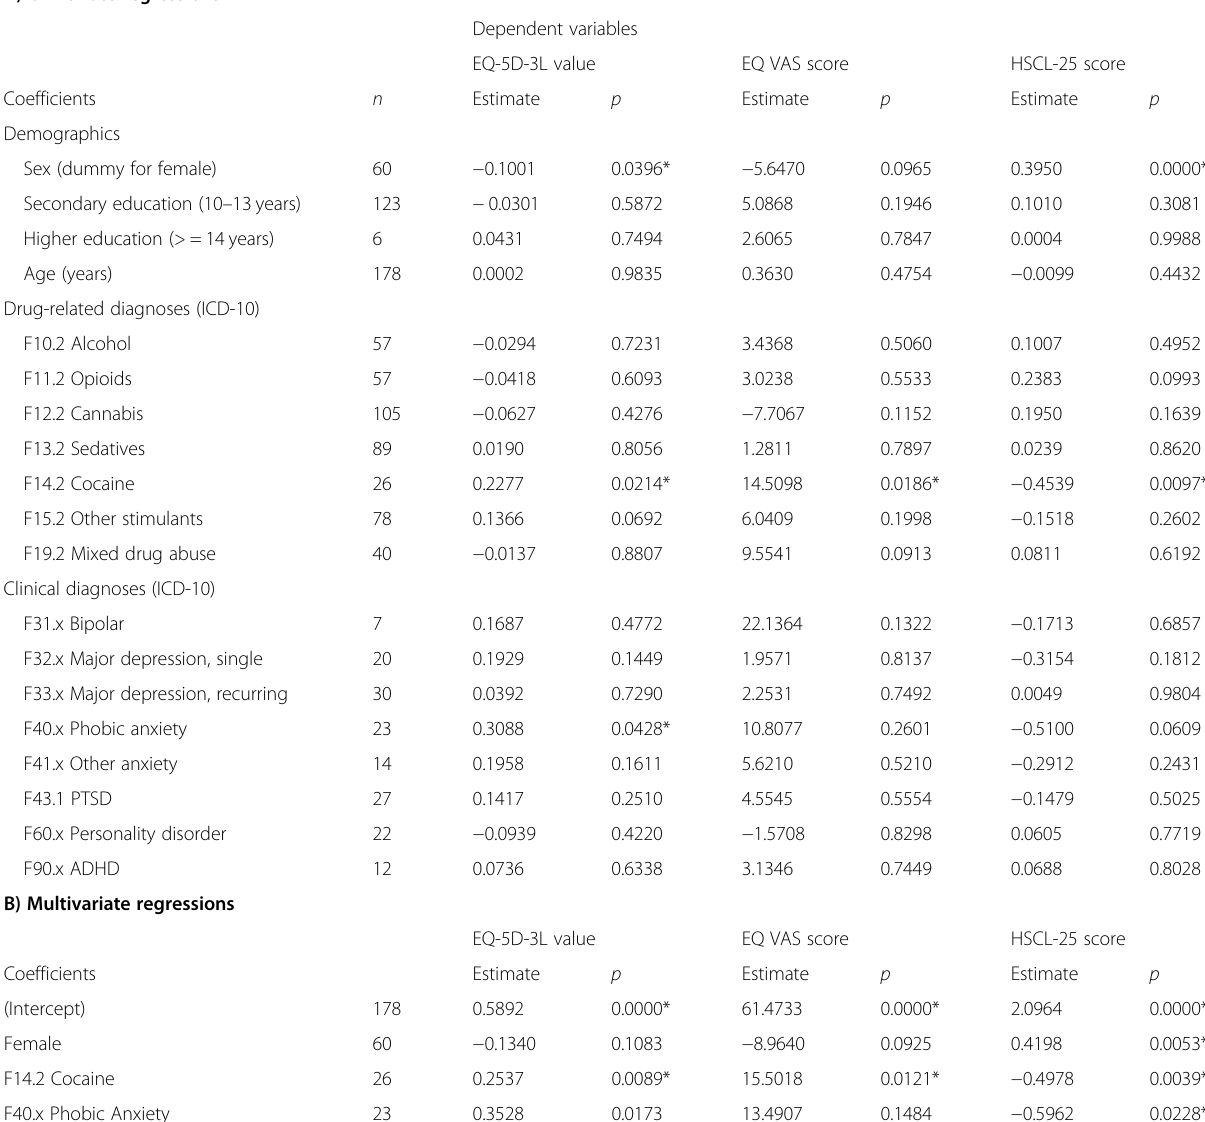
Table 3 Regressions predicting EQ-5D-3L index value, EQ-VAS, and HSCL-25